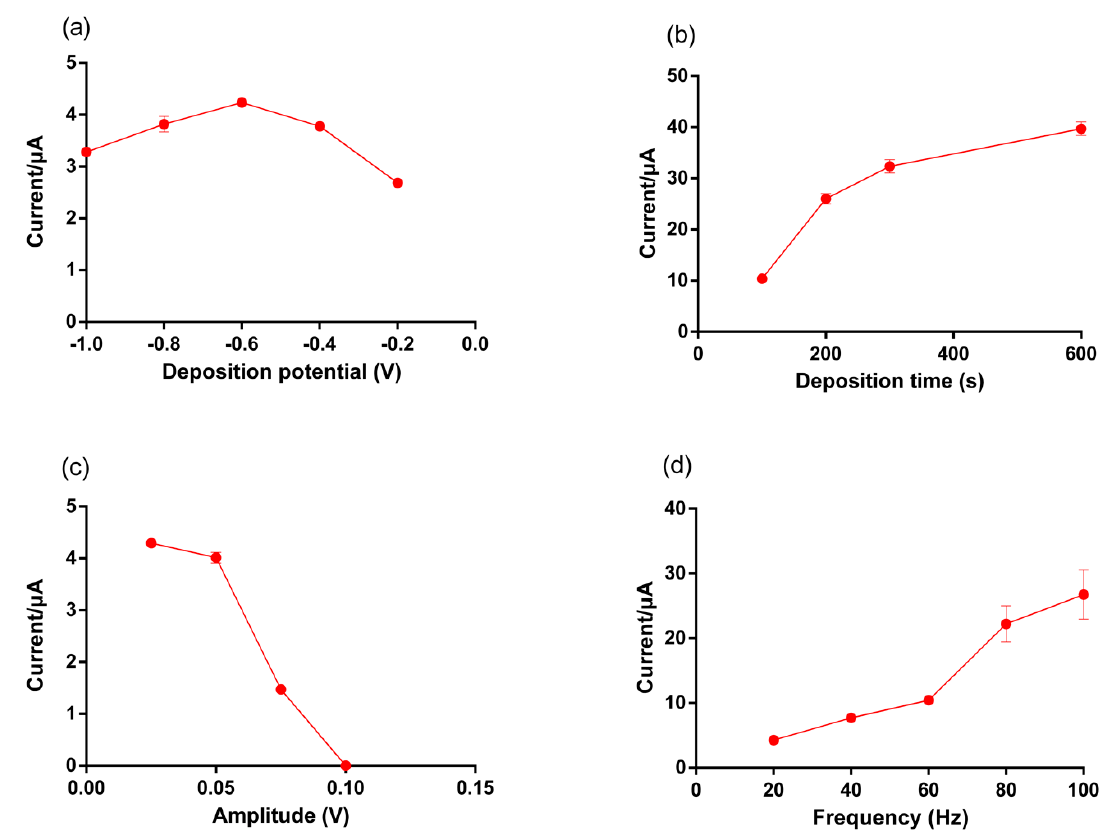
Figure 5. Optimization of ( a ) deposition potential, ( b ) deposition time, ( c ) amplitude and ( d ) frequency on the stripping peak currents of Hg 2+ using an AuNP-biopolymer-coated SPE sensor. Hg 2+ concentration was 10 ppb (0.1M AcB at pH 3.0). Individual data points represent the standard deviation (±SD) of duplicate experiments.